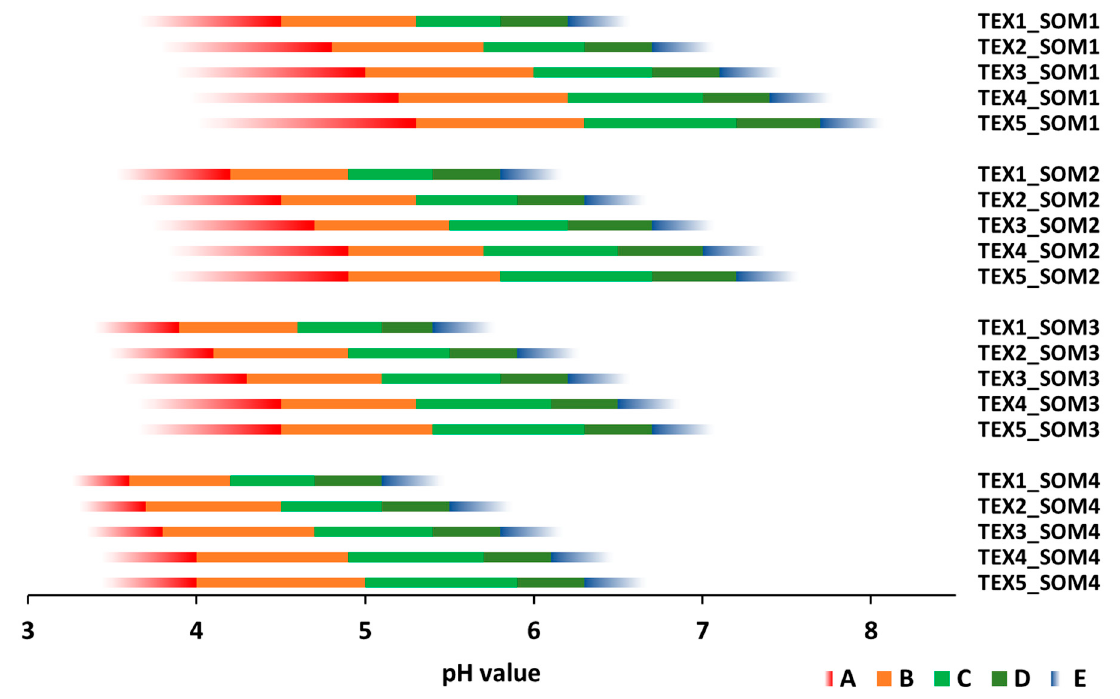
Figure 1. pH ranges of the lime supply statuses A–E (compare Table 1) in relation to the soil texture classes (TEX1–5) and the soil organic matter (SOM) classes (SOM1–4).